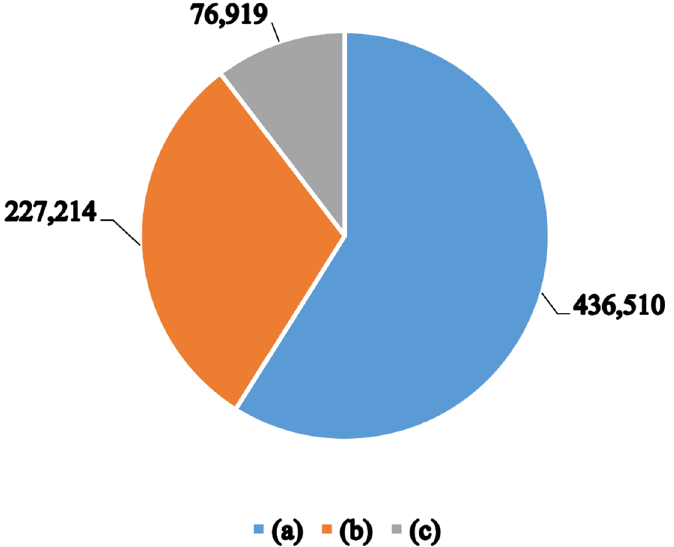
Fig 1. Annotation coverage for UniProtKB/TrEMBL reference proteome prokaryotic entries. (a) represents entries we could cover which lack pathway annotation, (b) represents entries we could cover which already have pathway annotation, and (c) represents entries we could not cover which already have pathway annotation.